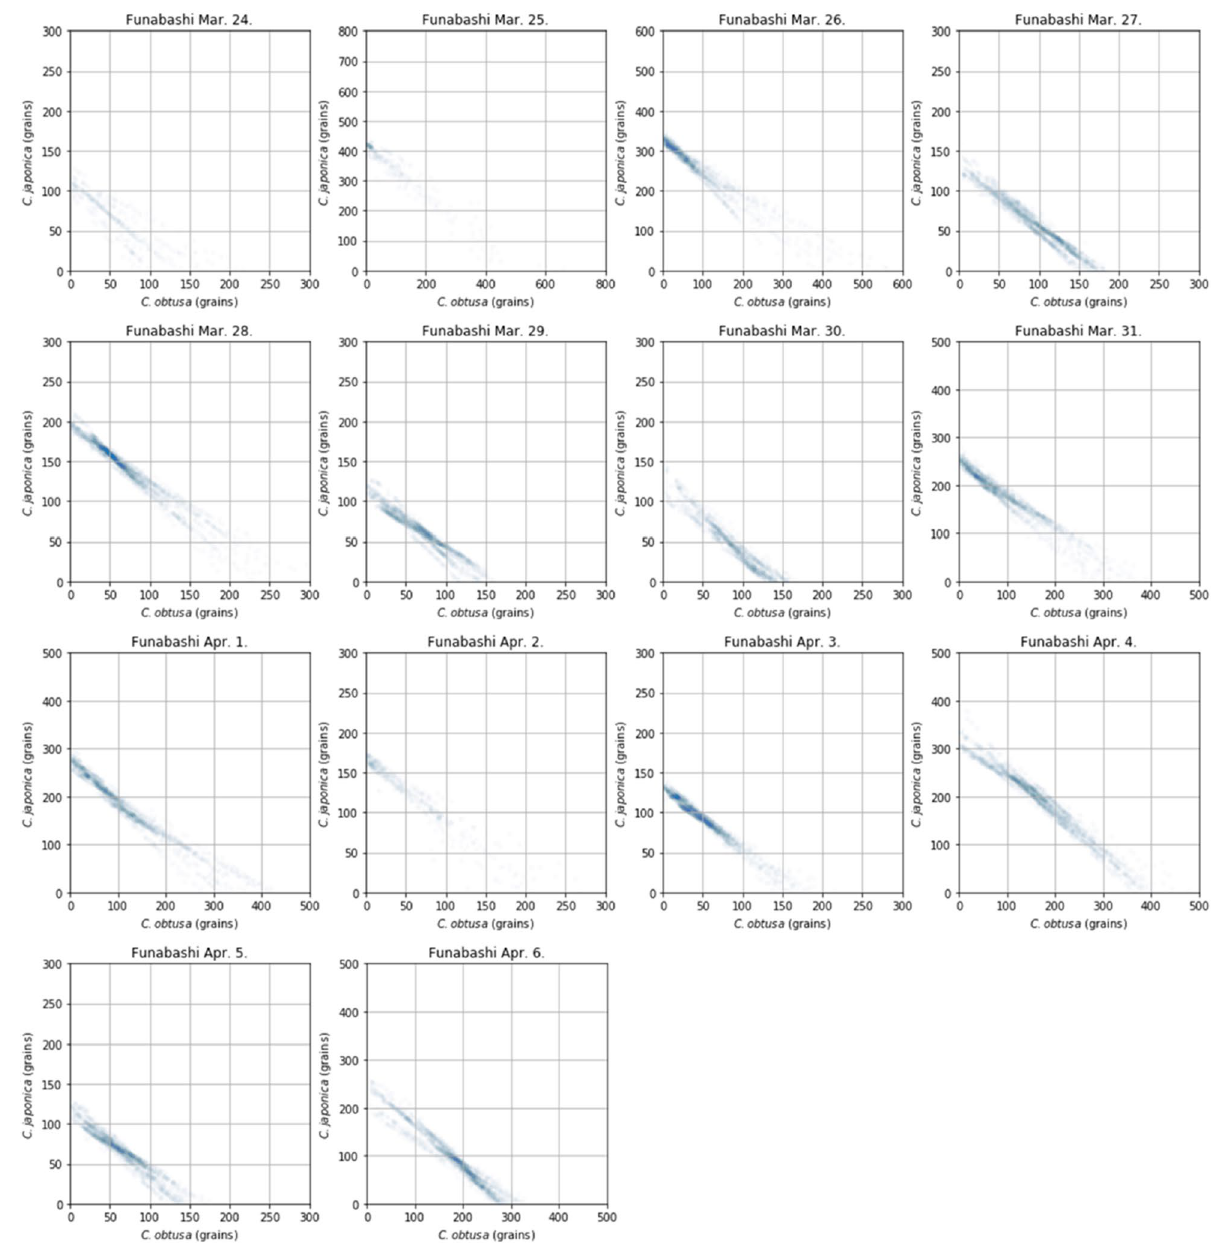
Figure 7. Outputs from the AME system (alpha =